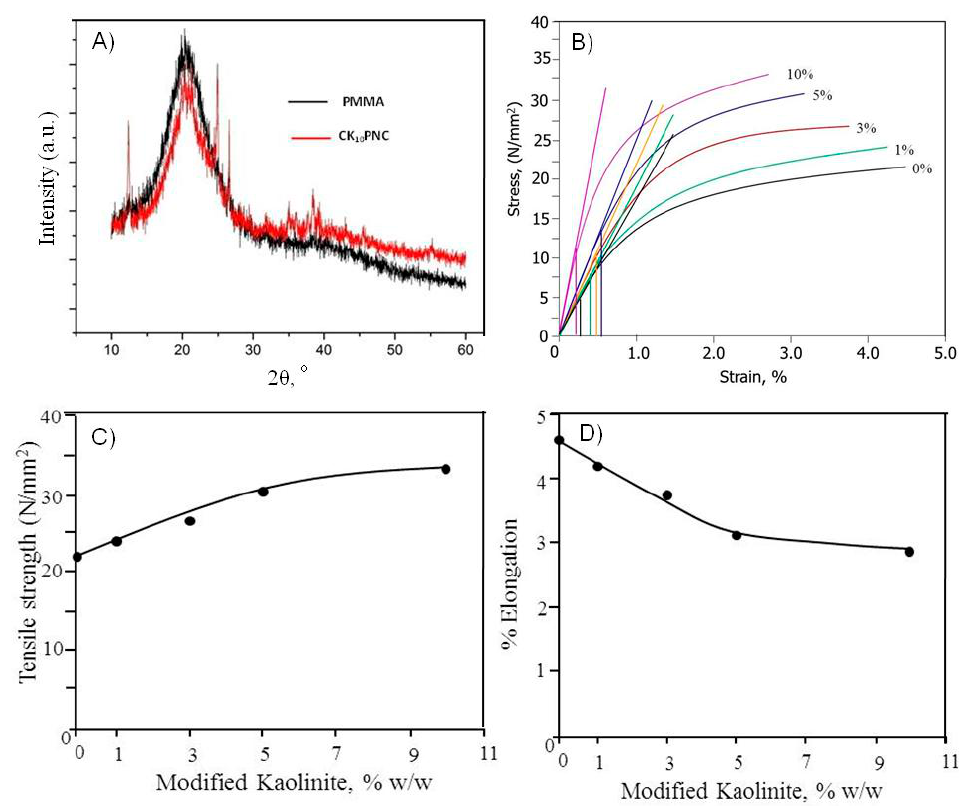
Figure 2. XRD patterns of CK 0 PNC, CK 10 PNC. ( A ) Stress versus strain (%) curve. ( B ) The effect of modified kaolinite on the tensile strength (N/mm 2 ) of nanocomposite films. ( C ) The effect of CCMK on the elongation at break (%) of the PMMA/CCMK nanocomposite films ( D ).